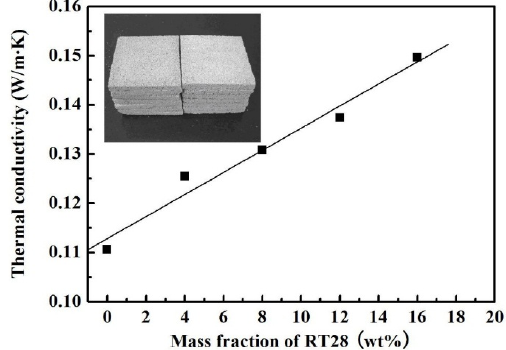
Figure 6. Relation between the thermal conductivity of the boards and the mass fraction of RT28 (the insert is the photograph of the boards).